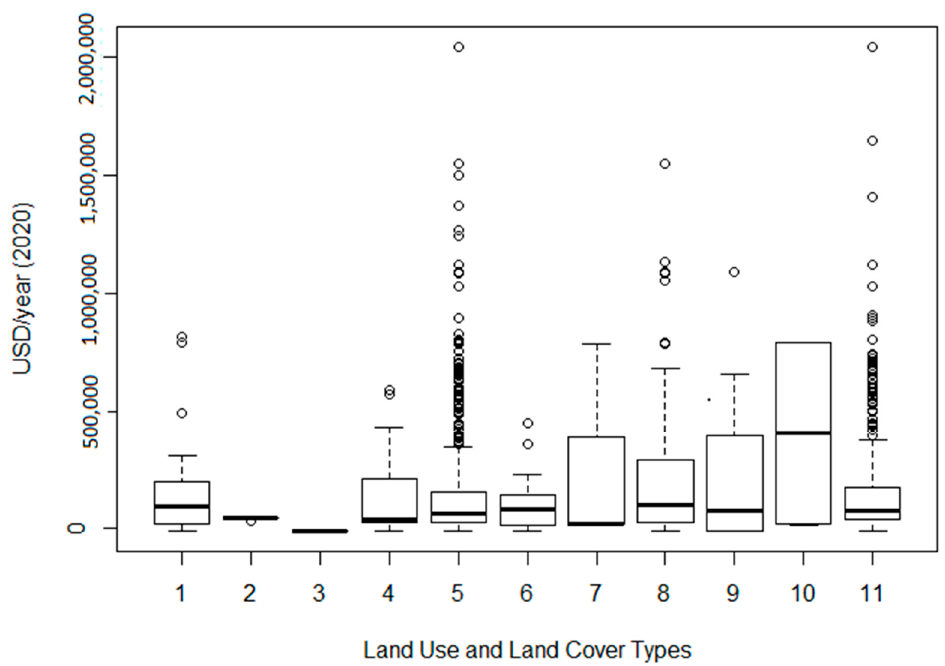
Figure 3. Box plot showing the variance between total economic value and LULC types. 1 = Waterbodies, 2 = Wetlands, 3 = Indigenous forest, 4 = Thicket and dense bush, 5 = Woodlands, 6 = Grasslands, 7 = Commercial agriculture, 8 = Subsistence agriculture, 9 = Forest plantations, 10 = Bare areas, and 11 = Built-up areas .